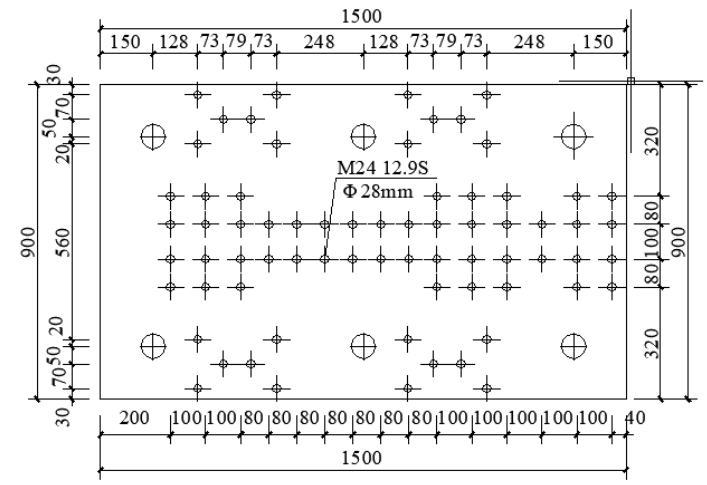
Figure 1. Elevation of specimen 1 (units: mm).